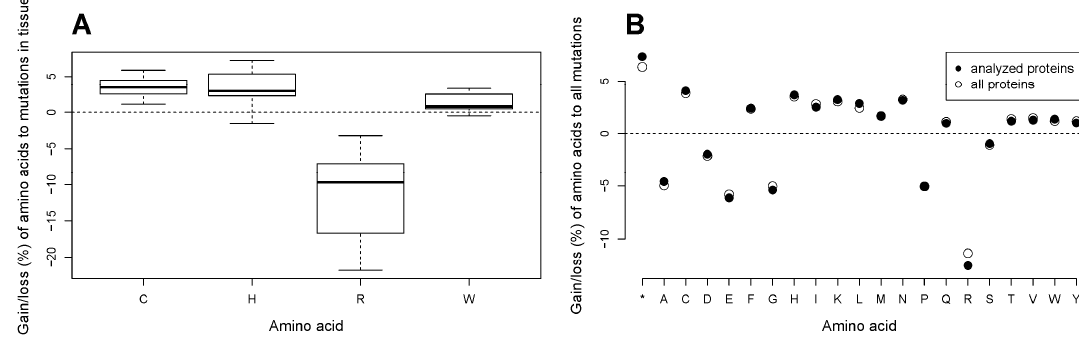
Figure 9. ( A ) Rates of gain/loss of cysteine, histidine, arginine, and tryptophan in the analyzed proteome subset in 23 tissue types in the COSMIC database. The data are calculated as percentages of net gains or losses of the amino acids to the total number of amino acid substitutions in the analyzed proteome subset. ( B ) Comparison of gain/loss of amino acids between the analyzed proteome subset and the total set of proteins in the COSMIC database. The rates of gains/losses of amino acids are calculated as ratios of the net gain or loss of each amino acid to the total number of substitutions in the dataset in both cases.